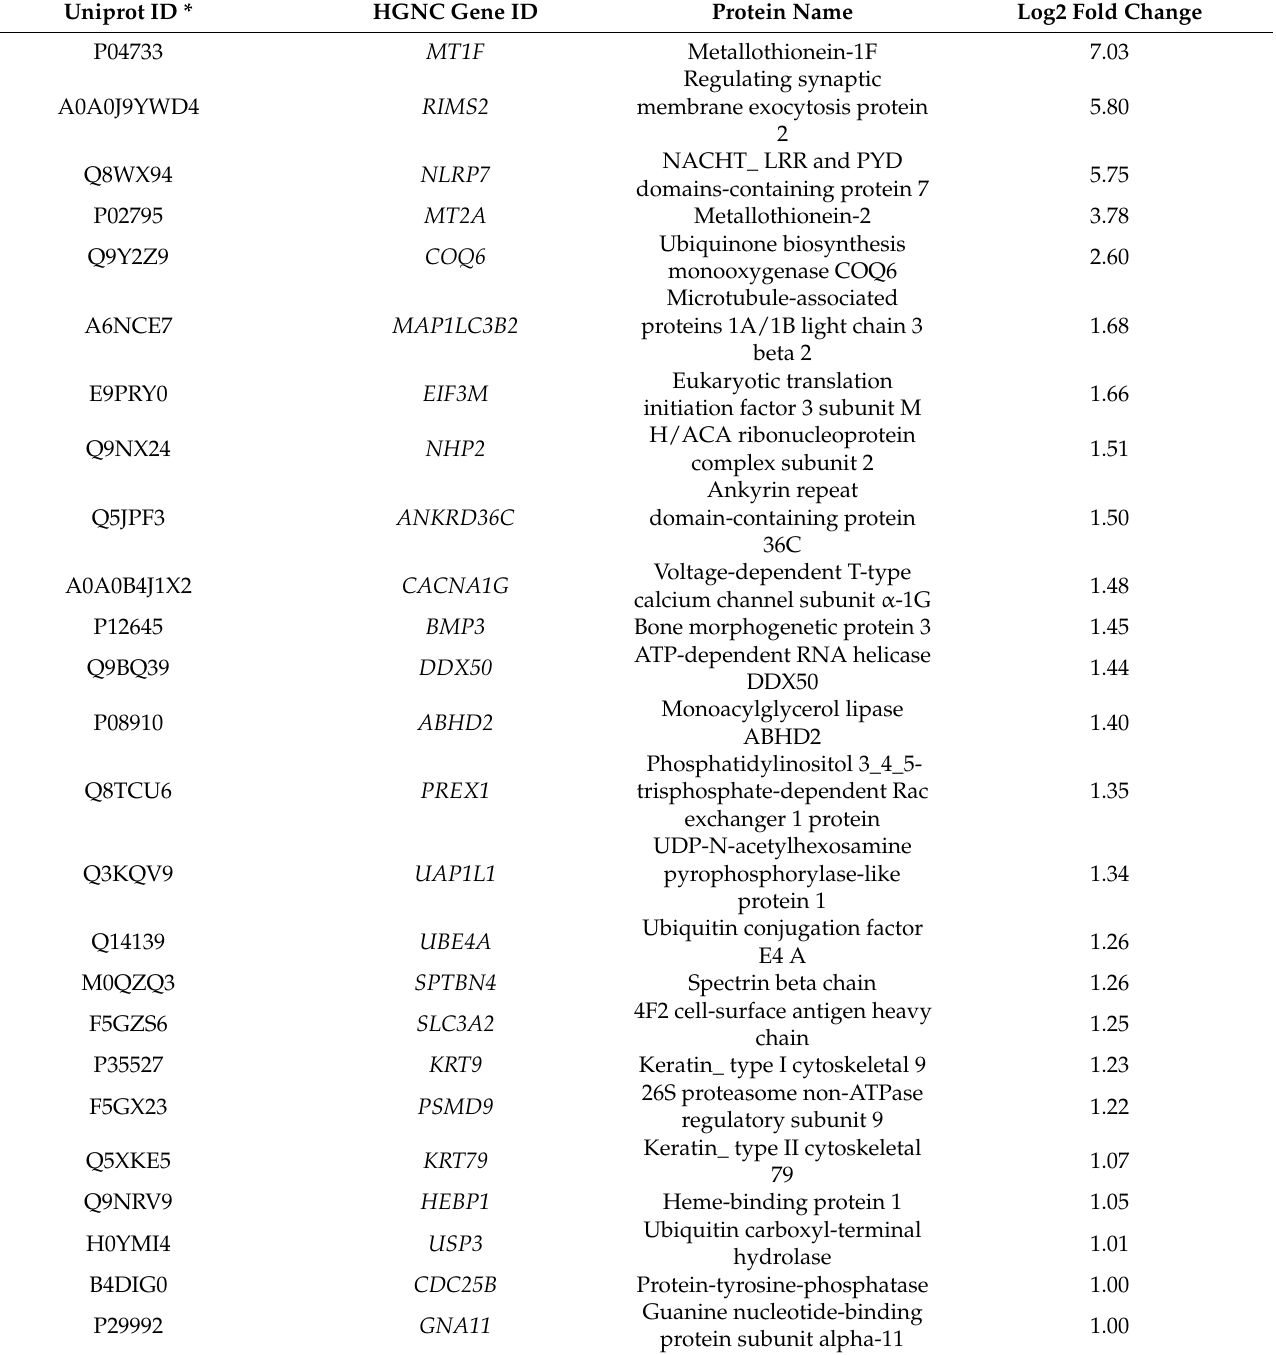
Table 2. Significantly upregulated proteins in cannabidiol-treated MCF7